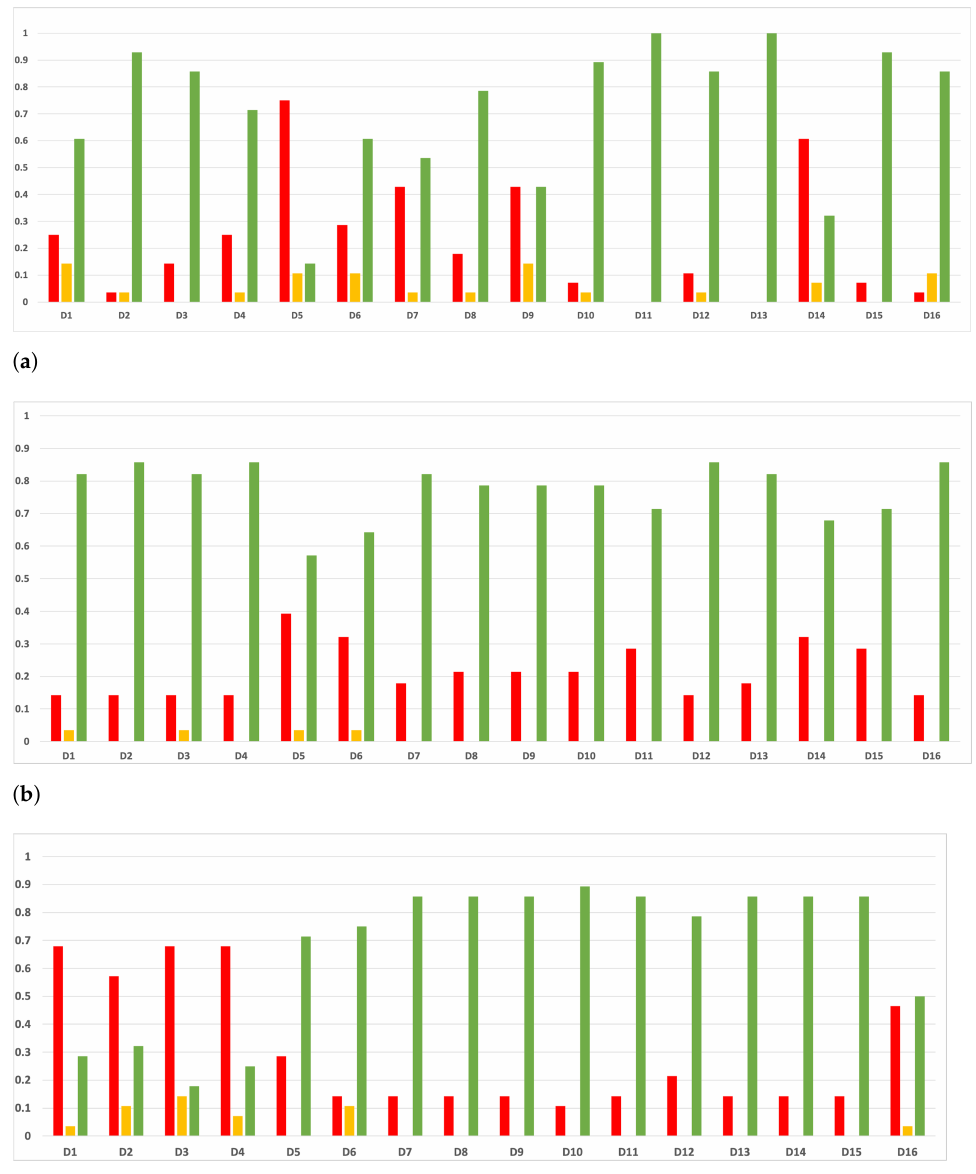
Figure 17. Experiment 1: consistency per dataset. Rate of validity with the accuracy and time complexity. ( a ) Rate of vx per dataset in RF. In axis X, the dataset. In axis Y, the rate of RHOASo for each class of validity. ( b ) Rate of validity per dataset in GB. In axis X, the dataset. In axis Y, the rate of RHOASo for each class of validity. ( c ) Rate of validity per dataset in MLP. In axis X, the dataset. In axis Y, the rate of RHOASo for each class of